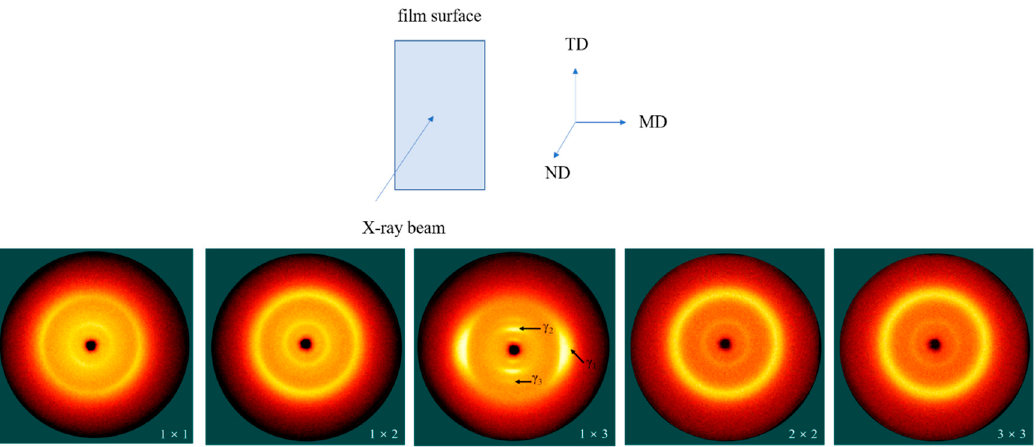
Figure 2. Surface (TD–MD plane) 2D-WAXS patterns for the PA510/SiO 2 films. ND is the normal direction. And the 1 × 1, 1 × 2, 1 × 3, 2 × 2 and 3 × 3 represent the stretching ratio (TD × MD) of the films.